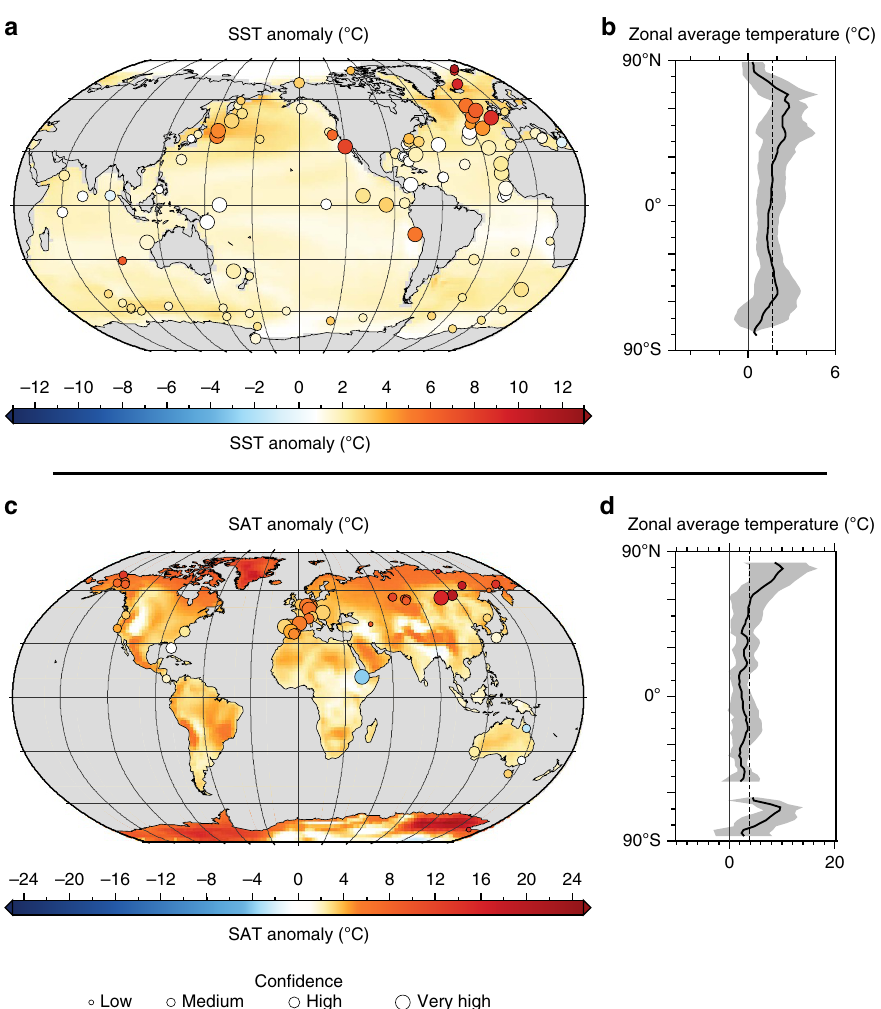
Figure 5 | Comparison of Data and Models. International Panel on Climate Change (IPCC) data model comparison. Comparison of PRISM proxy data and the PlioMIP multimodel mean (MMM) simulation, ( a ) circles are PRISM SSTanomalies, ( b ) zonally averaged PlioMIP MMM SSTanomalies, ( c ) circles are PRISM land surface air temperature (SAT) anomalies, ( d ) zonally averaged MMM SATanomalies. Zonal MMM gradients ( b , d ) are plotted with a shaded band indicating 2 s . Site-specific temperature anomalies estimated from PRISM proxy data are calculated relative to present site temperatures and are plotted ( a , b ) using the same colour scale as the model data, and a circle-size scaled to estimates of data confidence 9–11 . Modified from Box 5.1, Fig. 1, ref.